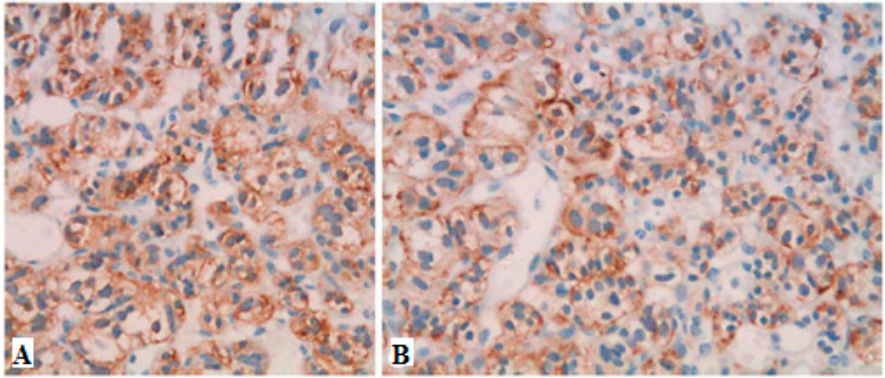
Figure 4. Immunohistochemistry showing strong positive staining for chromogranin A ( A ) and PP ( B ) in a case of PPOMA